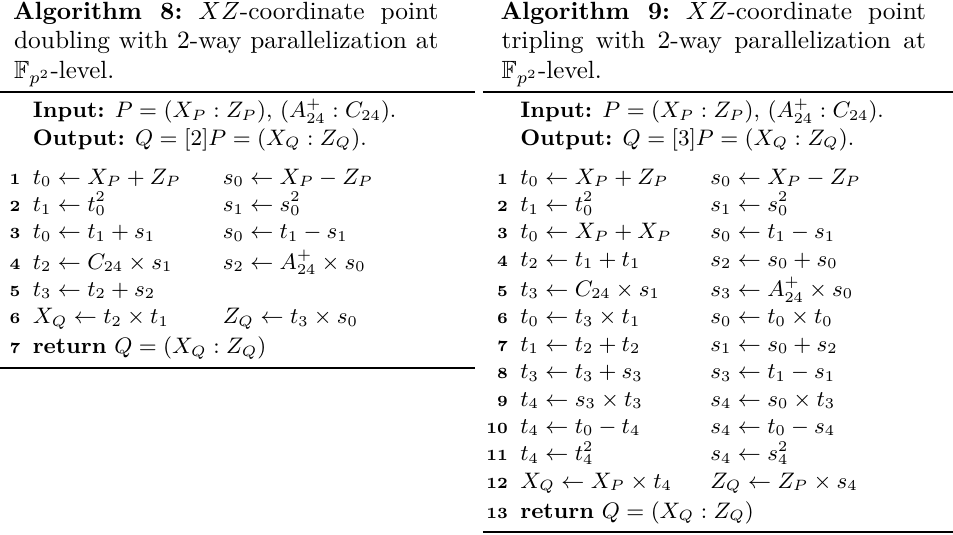
Algorithm 8: XZ -coordinate point doubling with 2-way parallelization at F -level. p 2